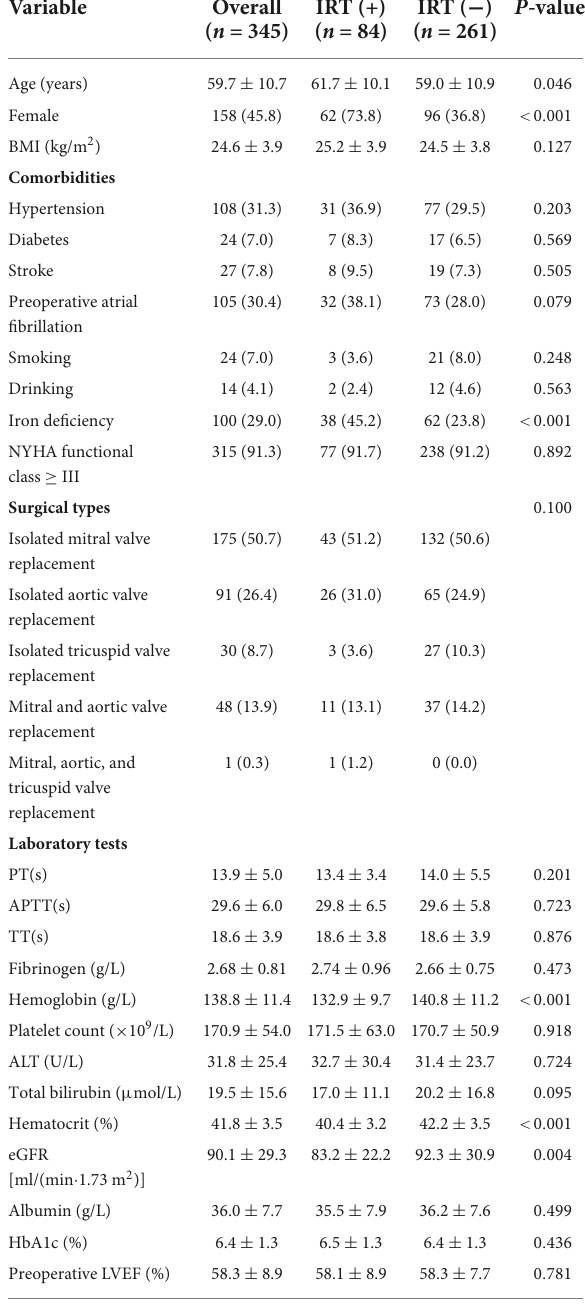
TABLE 1 Baseline characteristics of the two